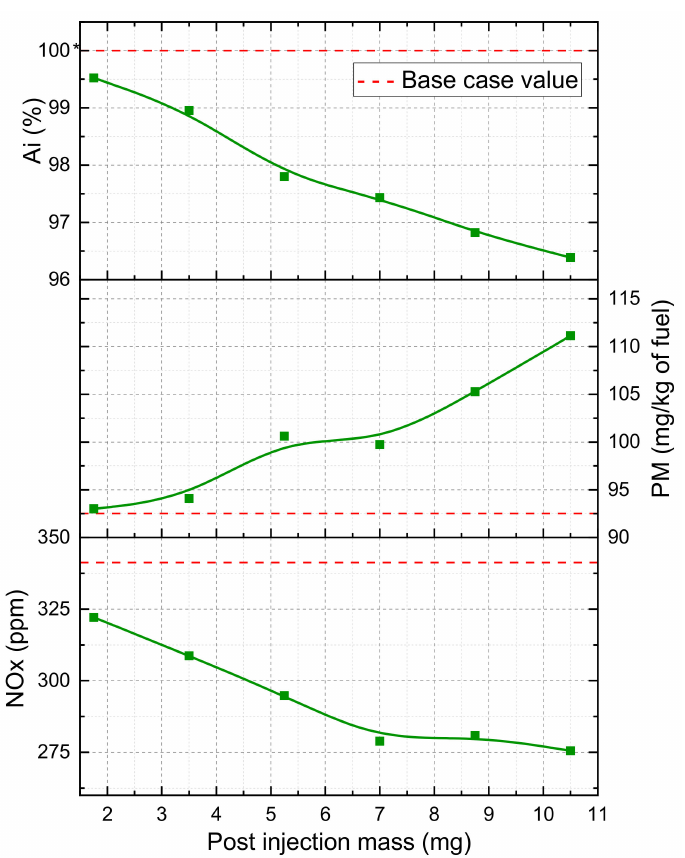
Figure 21. The post injection fuel mass variable influence on combustion process and emissions.